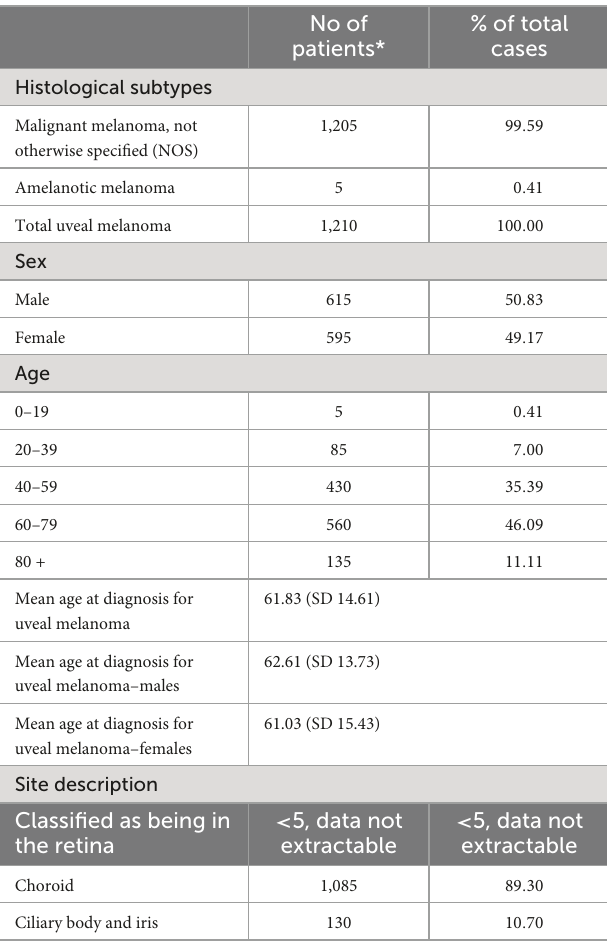
TABLE 1 Demographic characteristics of patients with uveal melanoma in Canada diagnosed between 2011 and 2017.